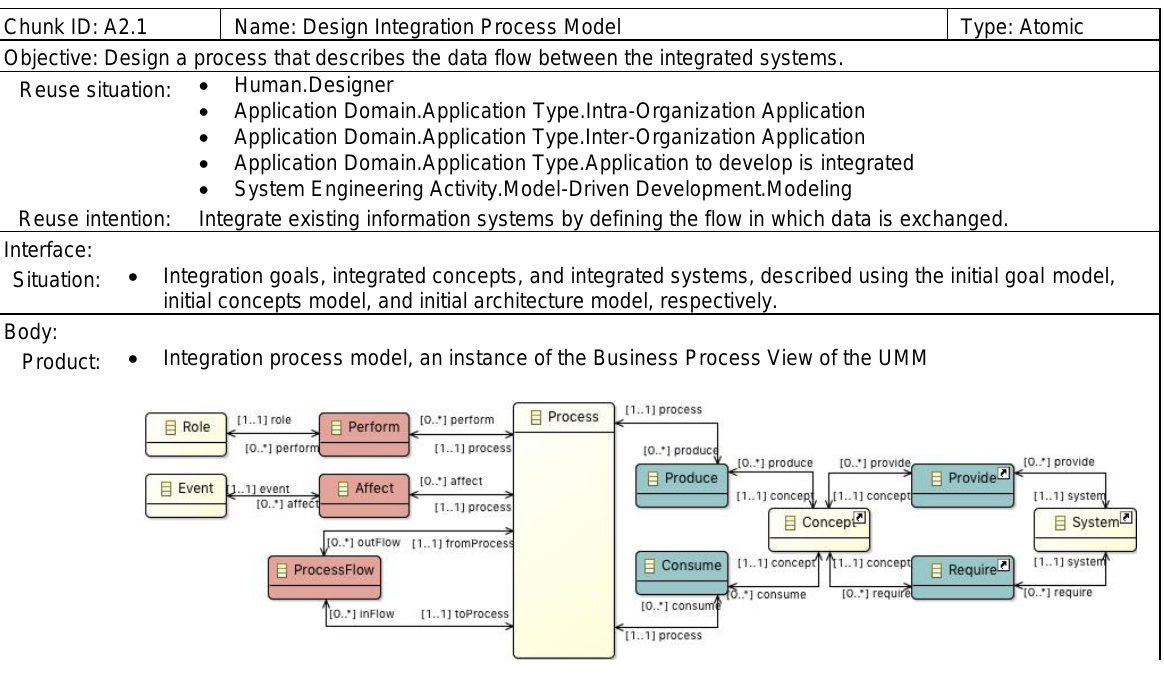
Table 5. Definition of method chunk